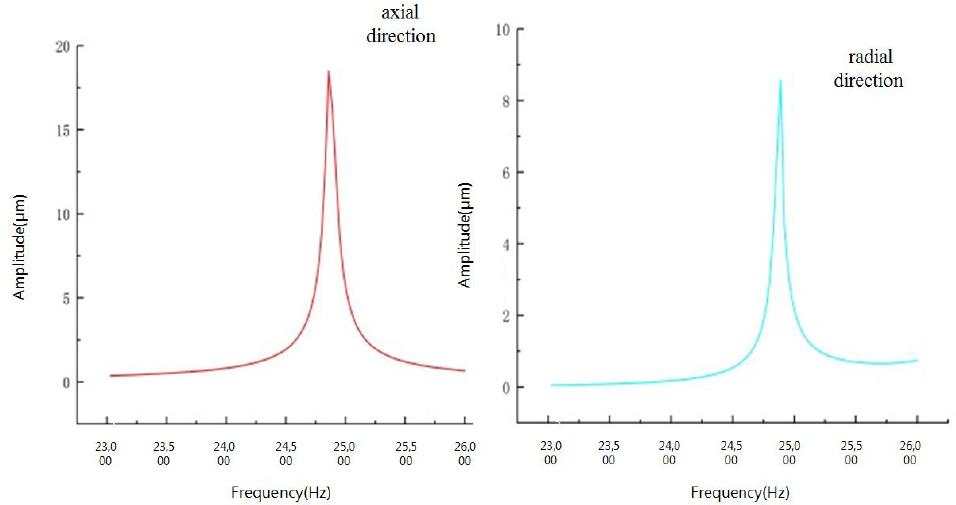
Figure 9. Longitudinal – torsional amplitude.